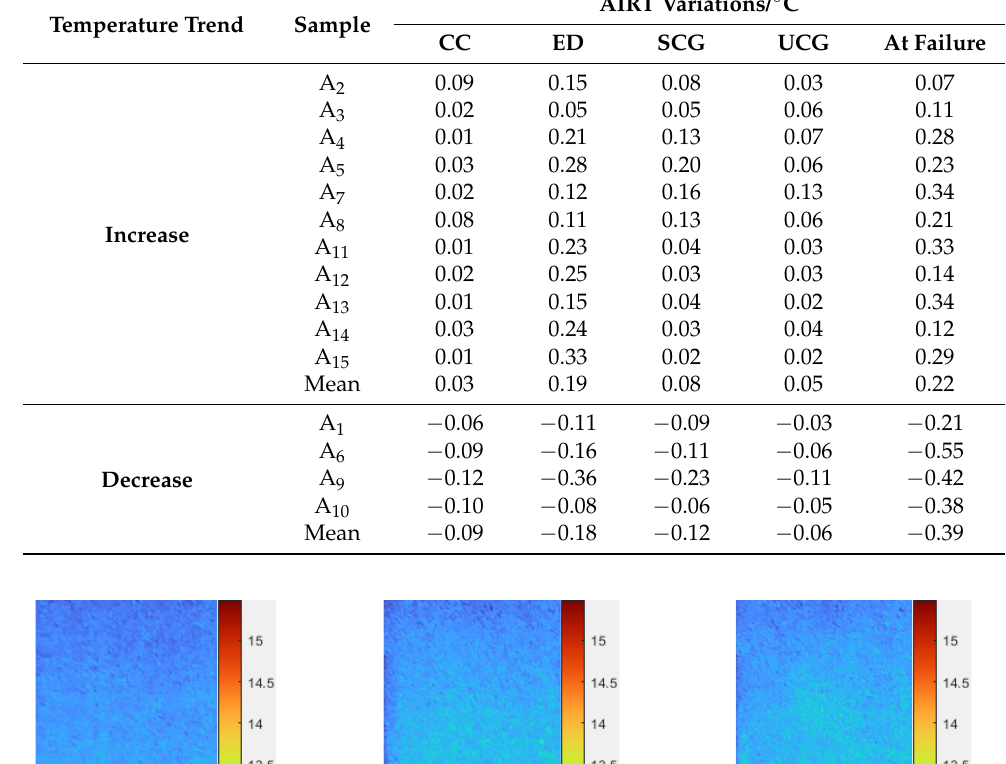
Table 1. AIRT variations of coal and rock samples at different damage evolution stages. Temperature Trend